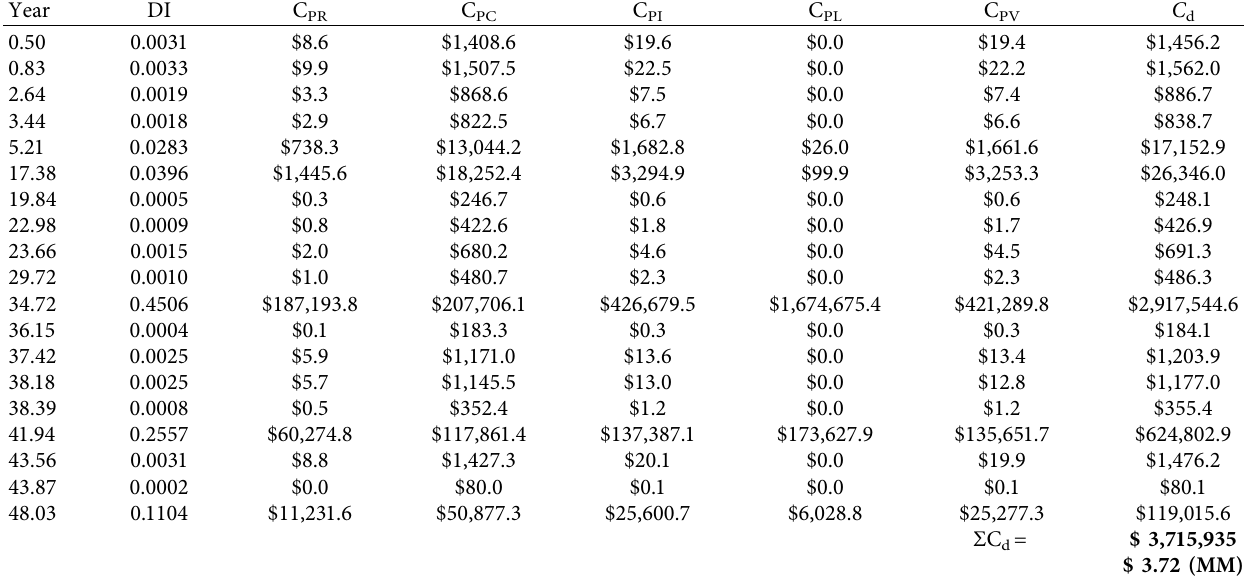
Table 7: Expected damage cost in the life-cycle of the 8-story building.